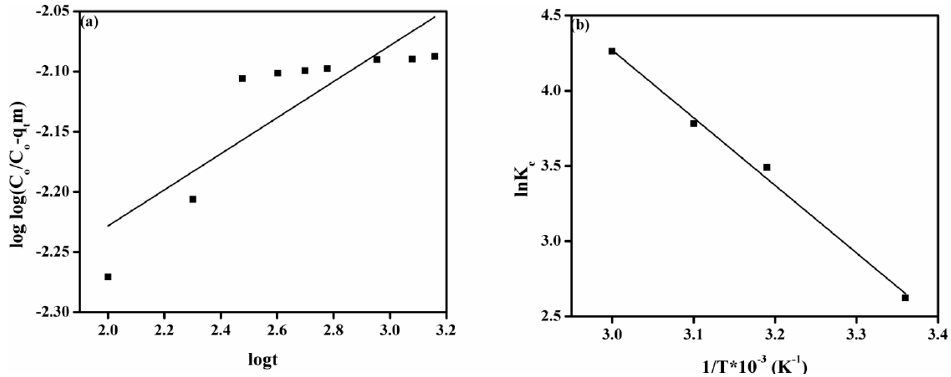
Figure 5. ( a ) Pseudo-first-order model, ( b ) pseudo-second model, ( c ) Elovich model, and ( d ) modified Freundlich equation for the adsorption of MO onto the DMEA-grafted AEM.